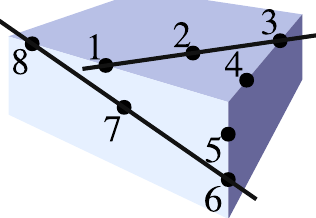
Figure 1 . Geometric con(cid:12)guration of k = 4, n = 8 labelled by permutation f 3,7,6,10,9,8,13,12 g in